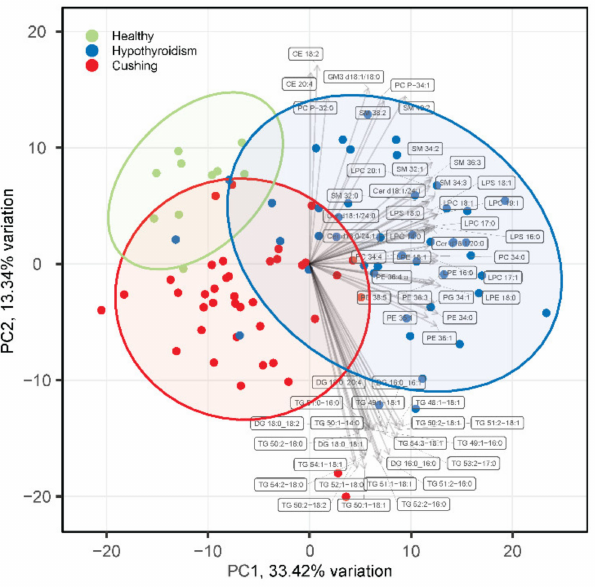
Figure 1. PCA analysis of serum lipidomes of healthy beagles (green), dogs with hypothyroidism (blue), and dogs with CS (red). The top 30 loading vectors are overlaid with corresponding lipid species names indicated. PC1 and PC2 in the axis labels correspond to principal component 1 and 2, respectively.